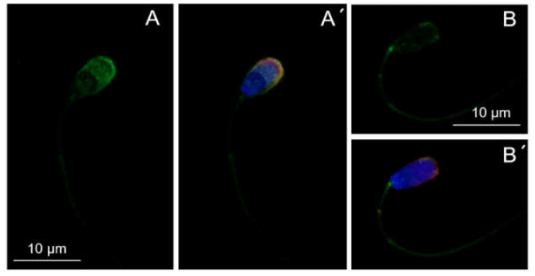
Figure 1. Localization of porcine MSMB in ejaculated ( A , A ’) and in vitro capacitated ( B , B´ ) spermatozoa with a specific polyclonal anti-MSMB antibody (green) by indirect immunofluorescent microscopy. Nucleus was counterstained with DAPI (4 (cid:48) ,6-diamidino-2-phenylindole) (blue) and acrosome with PNA (Peanut agglutinin) lectin